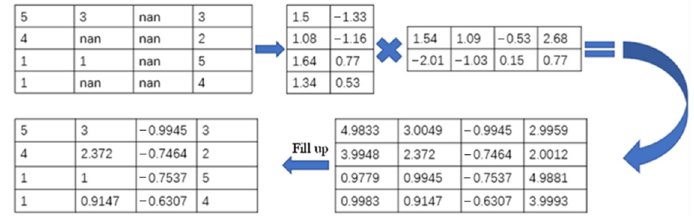
Figure 1. Matrix missing value prediction.